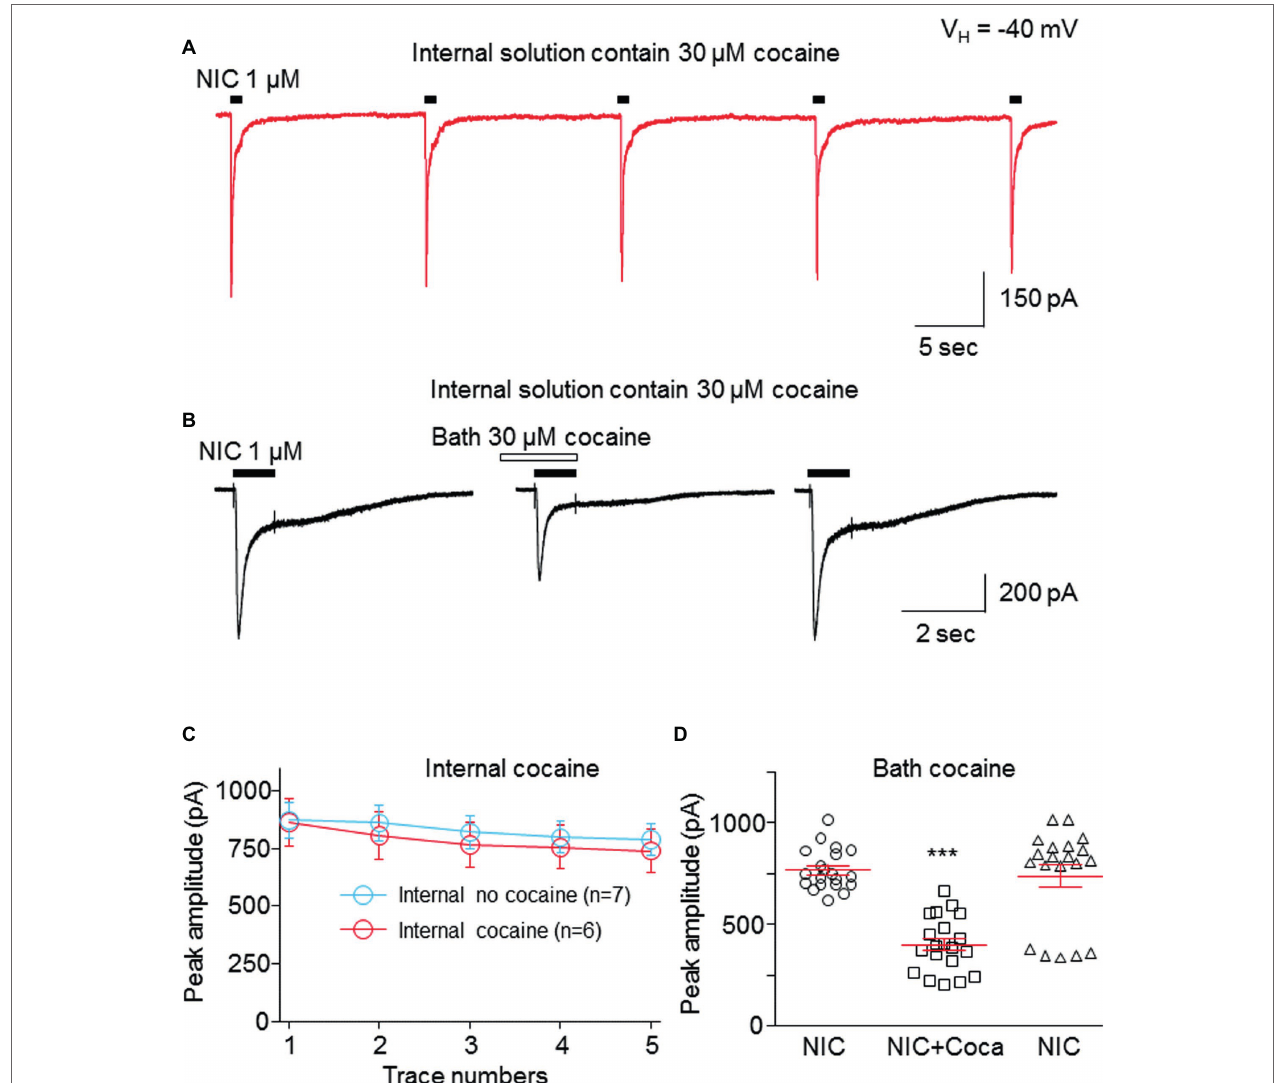
FIGURE 6 | Cocaine inhibits α 6*-nAChR-mediated current through the extracellular site. (A) Cocaine (30 μ M) was added to pipette solution. After the formation of whole-cell recording configuration for 3–5 min, 1 μ M NIC was repetitively applied (1 s NIC exposure repeated five times at 15-s interval). The same experimental protocol was also applied without internal cocaine as a control (see Figure 7C ). (B) After recording from the protocol in (A) , bath-applied cocaine (30 μ M with 1 min pretreatment) to the same cell showed an inhibitory effect. (C) Comparison of NIC responses with and without internal cocaine. (D) Statistical comparison of cocaine’s effect via bath application. *** p <